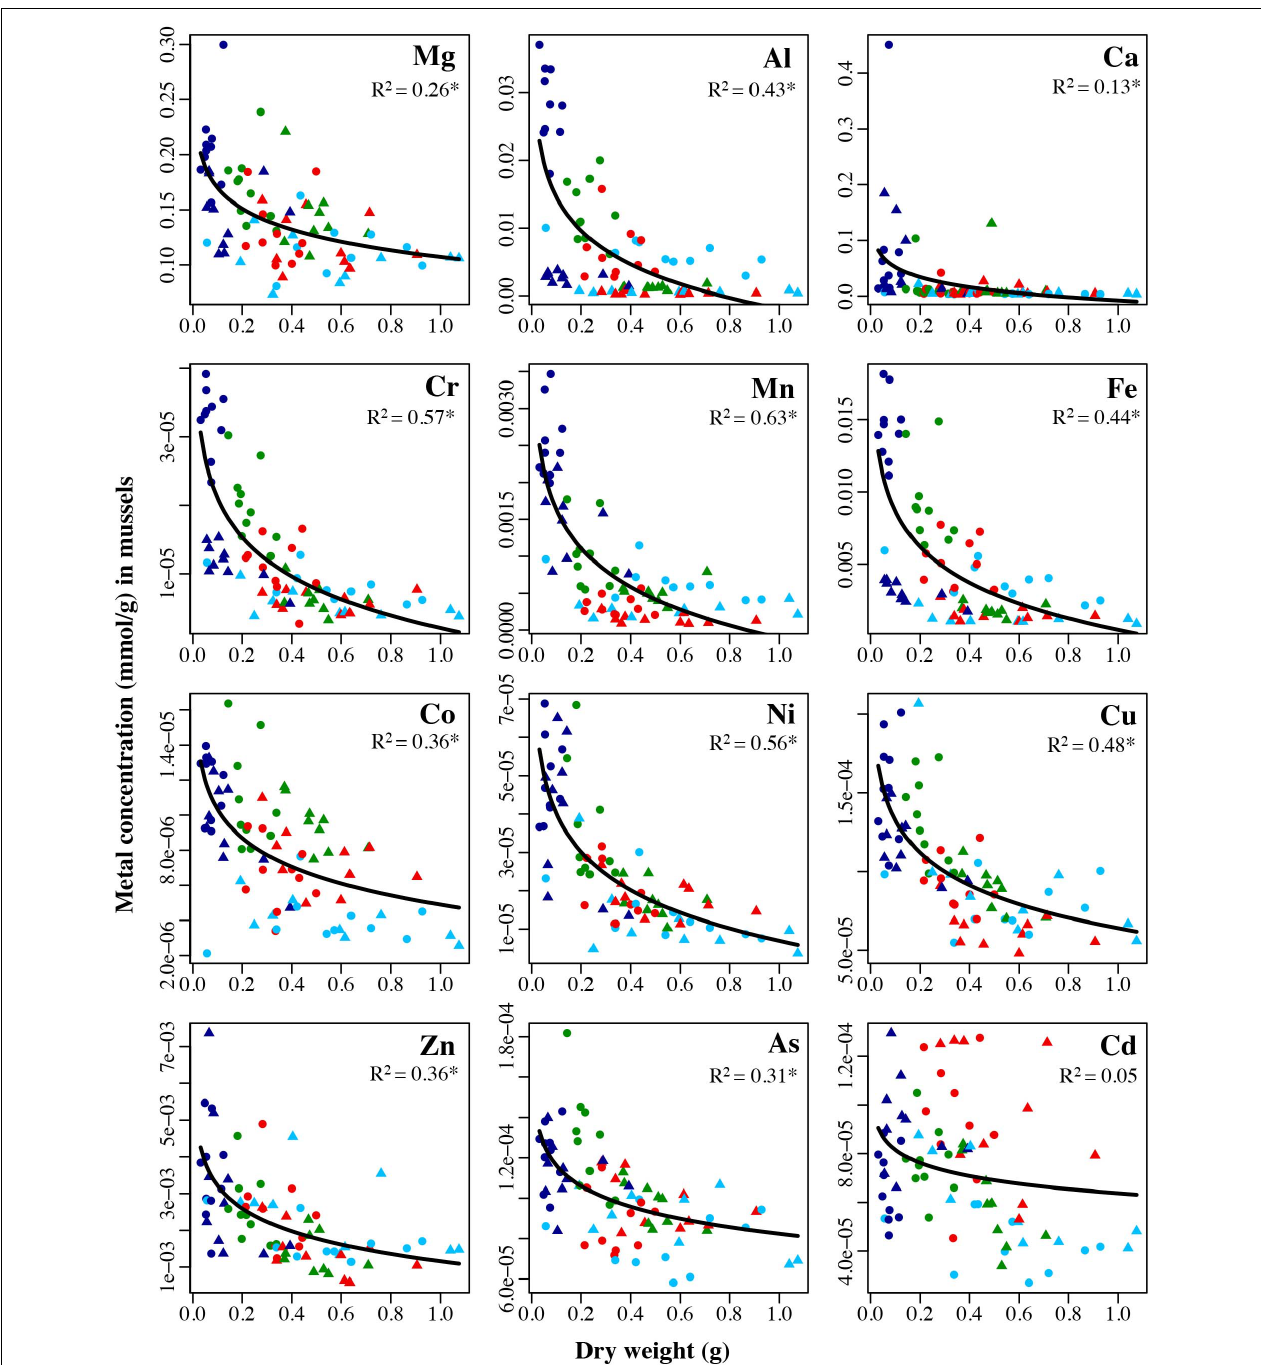
FIGURE 11 | Concentrations in mmol/g for each of the twelve analyzed trace metals in mussels held for 6 months (January: circles) and 1 year (July: triangles) in four locations: Point Wells 5 m (green), Dabob Bay 5 m (red), Carr Inlet 5 m (light blue), and Carr Inlet 20 m (dark blue), all plotted against the dry weight (grams) of the oysters. Adjusted R 2 values from exponential regression are shown in each panel. Asterisk indicates the R 2 value is significant after Bonferroni correction (alpha of 0.004). One mussel sample that weighed ∼ 0.15 g was not graphed to better view the majority of samples, but was included in analyses.